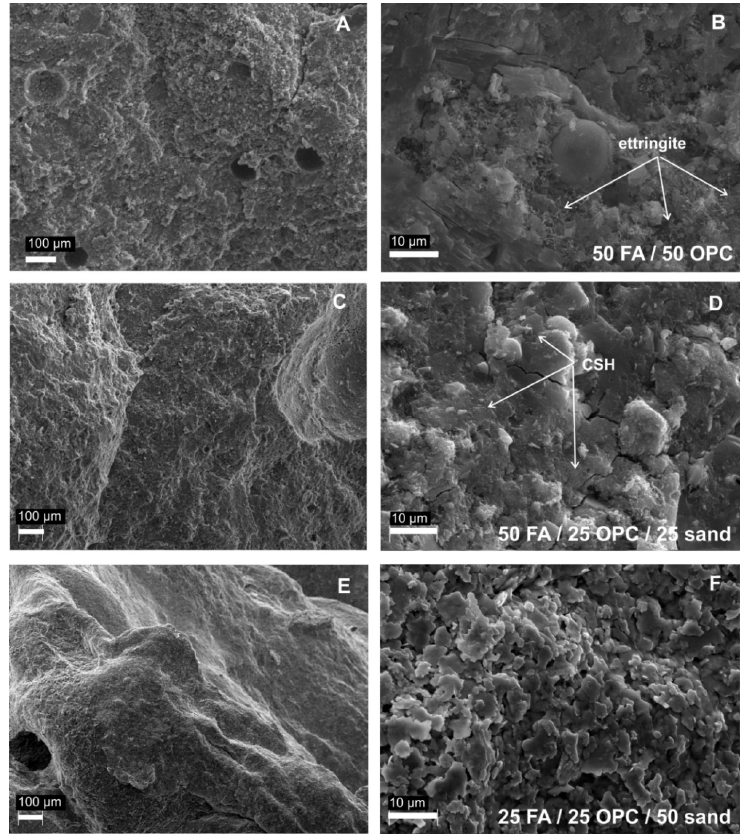
Figure 7. SEM backscattered electron images of pastes after 28 days of curing: ( A , B ) 50% CSA ‐ FA/50% OPC mixture; ( C , D ) 50% CSA ‐ FA/25% OPC/25% sand mixture; ( E , F ) 25% CSA ‐ FA/25% OPC/50% sand mixture.